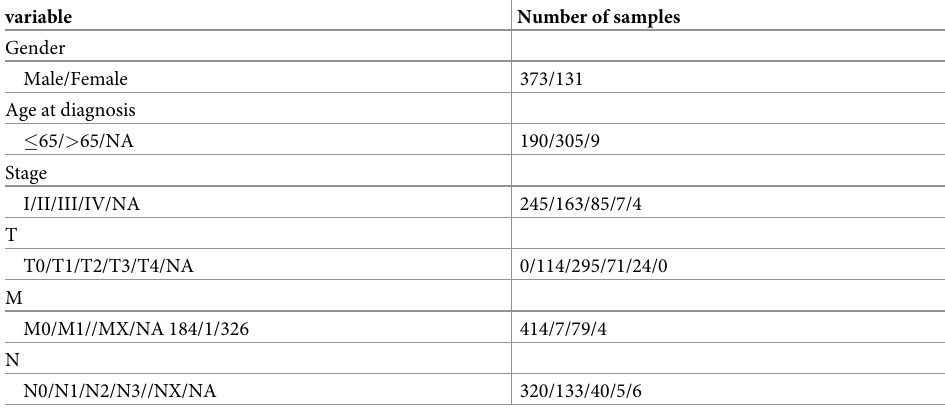
Table 1. Characteristics of LUSC patients in TCGA